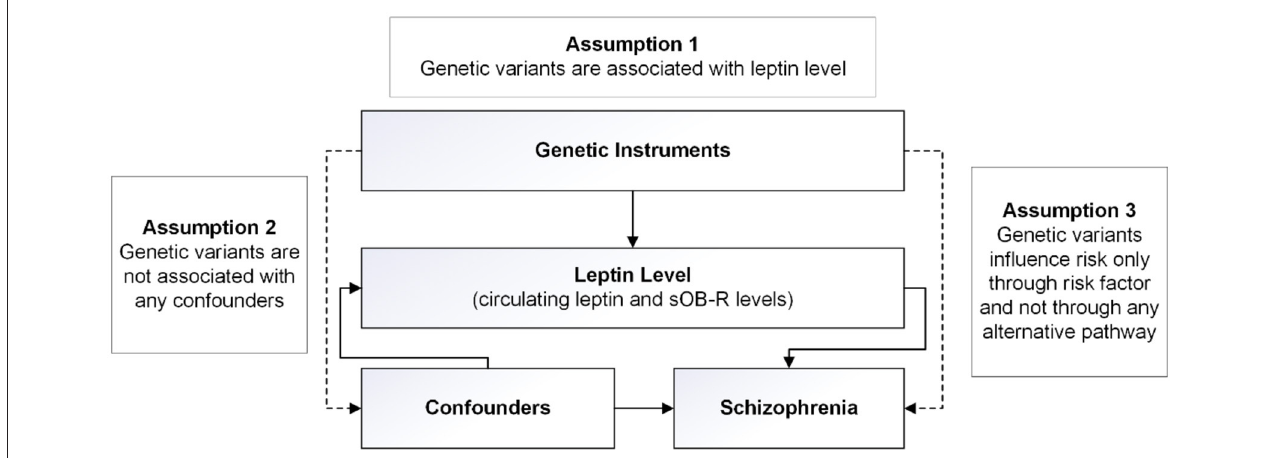
FIGURE 1 | Design of the two-sample Mendelian randomization study. Three basic assumptions were as follows: (1) the single-nucleotide polymorphisms (SNPs) should be strongly associated with leptin level; (2) the SNPs should not be associated with confounders; and (3) the SNPs should not be directly associated with schizophrenia.